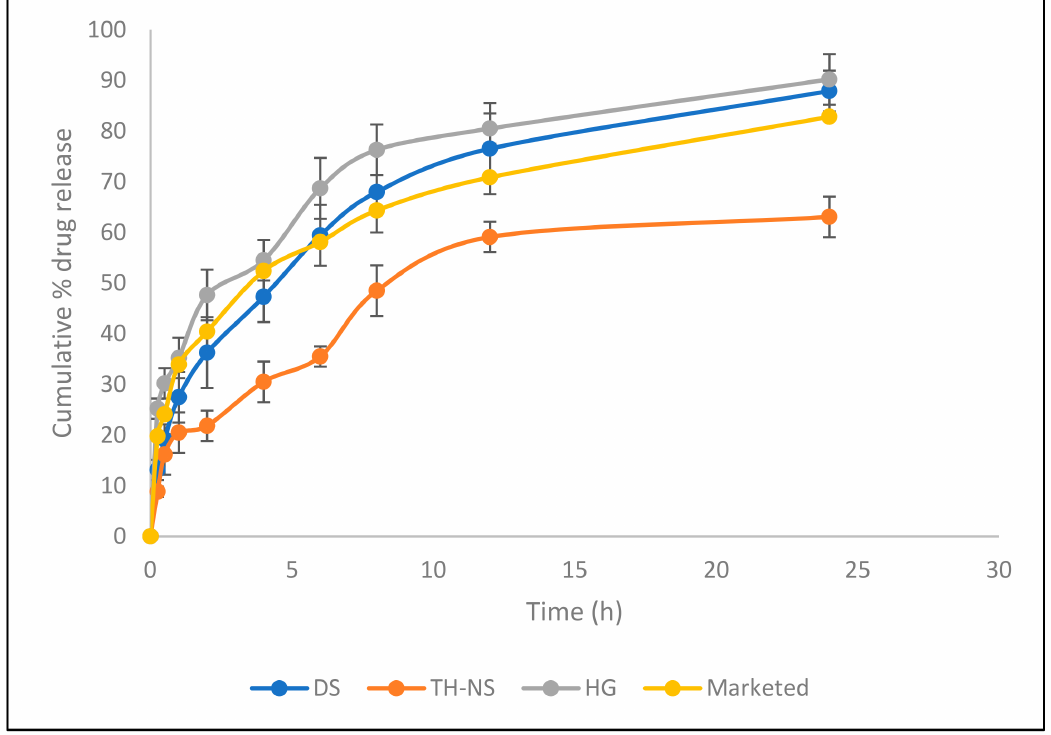
Figure 5. % cumulative in vitro drug